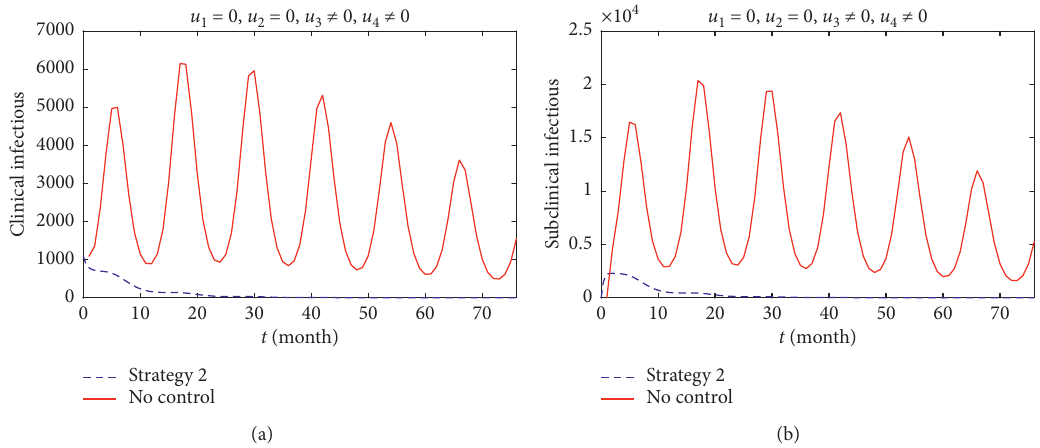
Figure 7: The time-series plots of I (a) and L (b) without (red line) and with (blue line) control Strategy